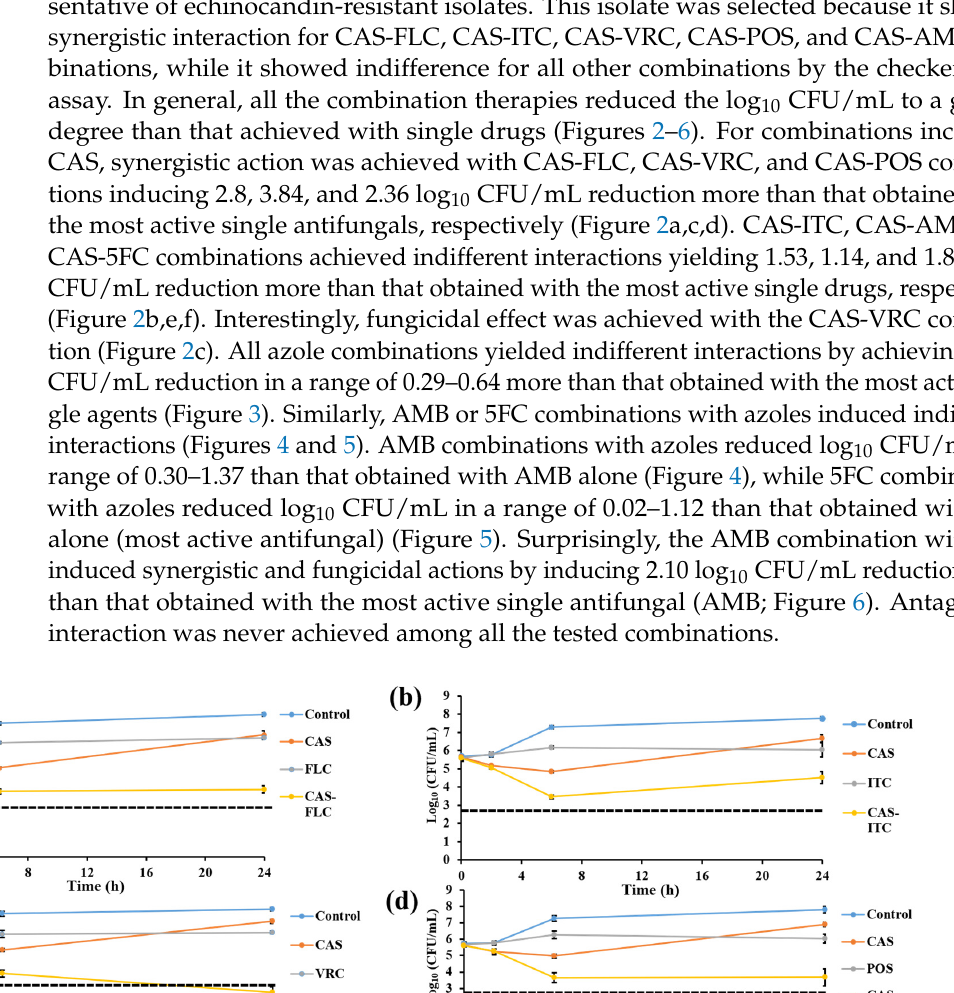
Figure 3. In vitro activities of azoles alone and in combinations including FLC-ITC 25–4 µg/mL ( a ), FLC-VRC 25–1 µg/mL; ( b ), FLC-POS 25–4 µg/mL; ( c ), ITC-VRC 4–1 µg/mL; ( d ), ITC-POS 4–4 µg/mL; ( e ), and VRC-POS 1–4 µg/mL; ( f ) against C. glabrata IFM60089 as determined by the time-killing assay. The detection limit was 20 CFU/mL. Dashed lines represent a >99.9% growth reduction compared with the initial inoculum size for determination of fungicidal activity. All azole com- binations showed indifferent interactions. Each data point represents the means ± standard deviation of results from two independent experiments.